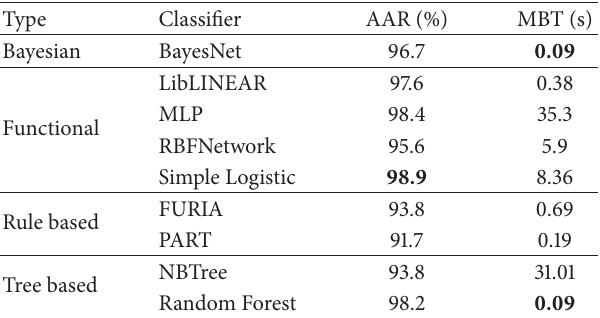
Table 2: Comparison of result for different classifiers: AAR: average accuracy rate, MBT: model building time.